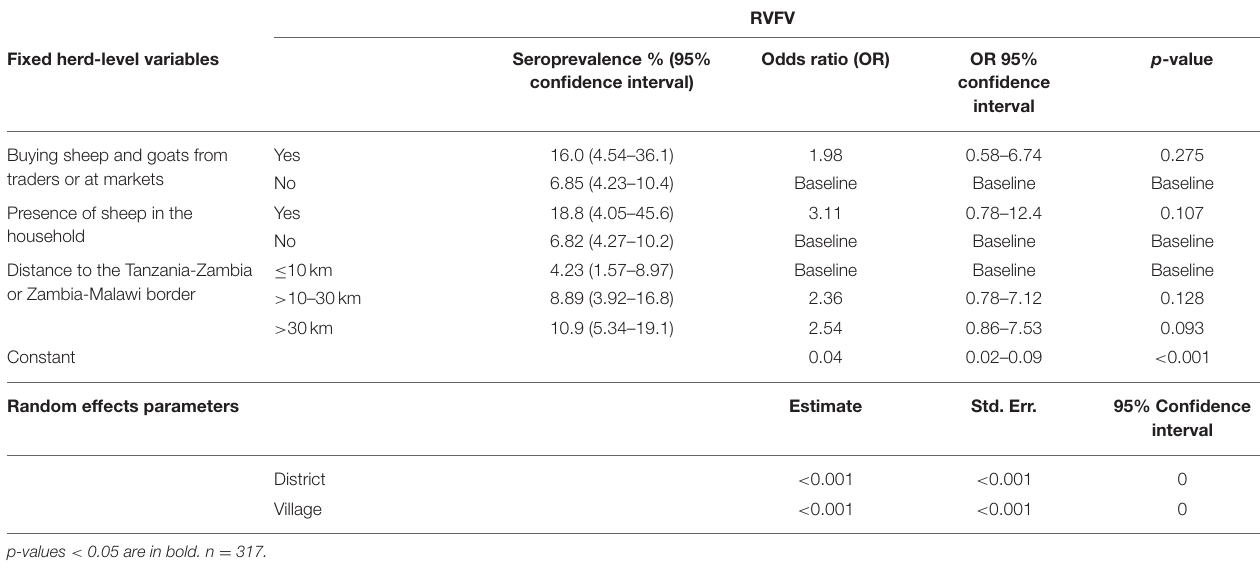
TABLE 11 | Predictor variables associated with herd-level seropositivity for RVFV.